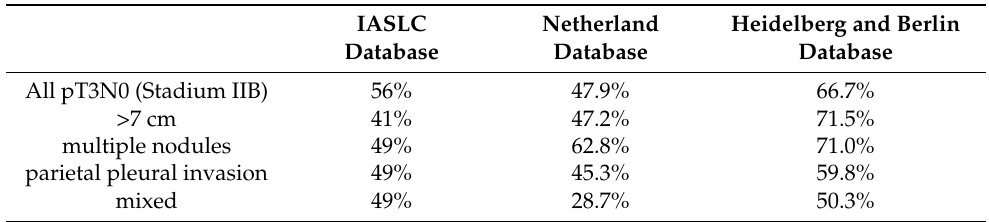
Table 3. Comparison of 5-y overall survival (OS) among subsets of patients with pT3N0 NSCLC (TNM-7).